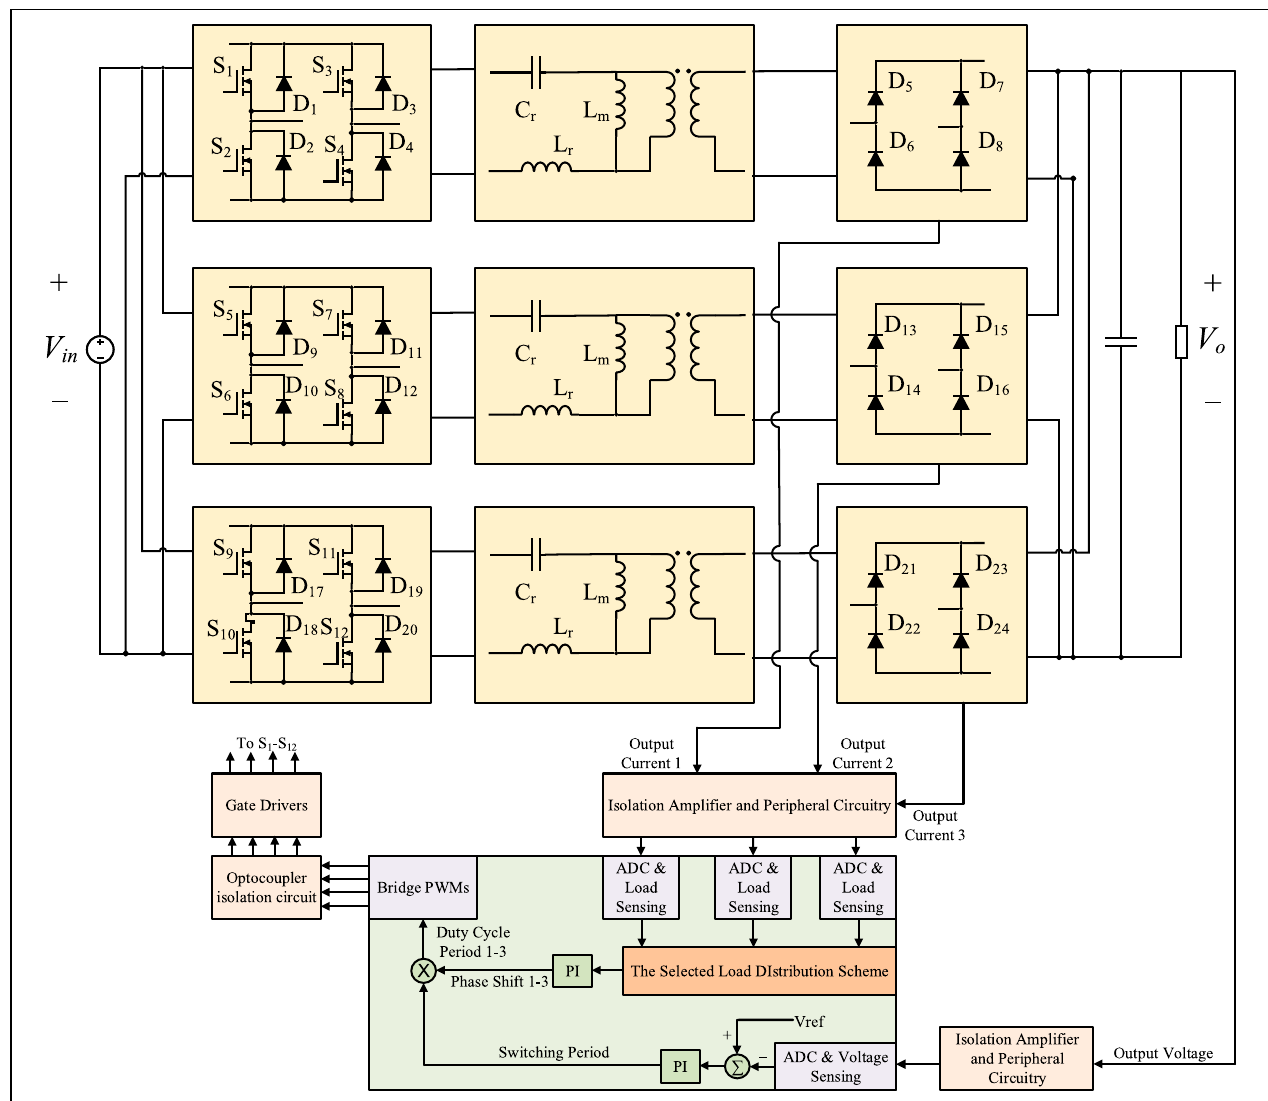
FIGURE 6 | Three-phase interleaved LLC resonant converter with a feedback